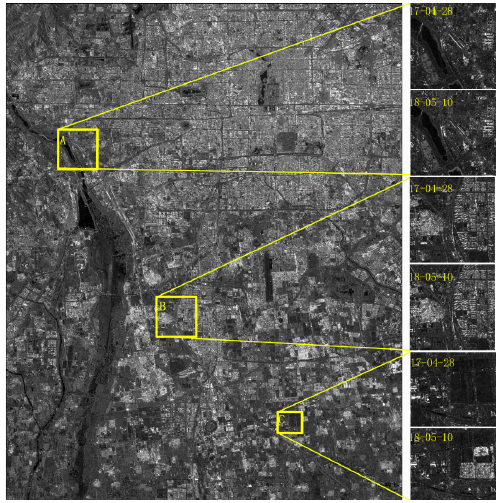
Figure 2. Image of Beijing dataset.